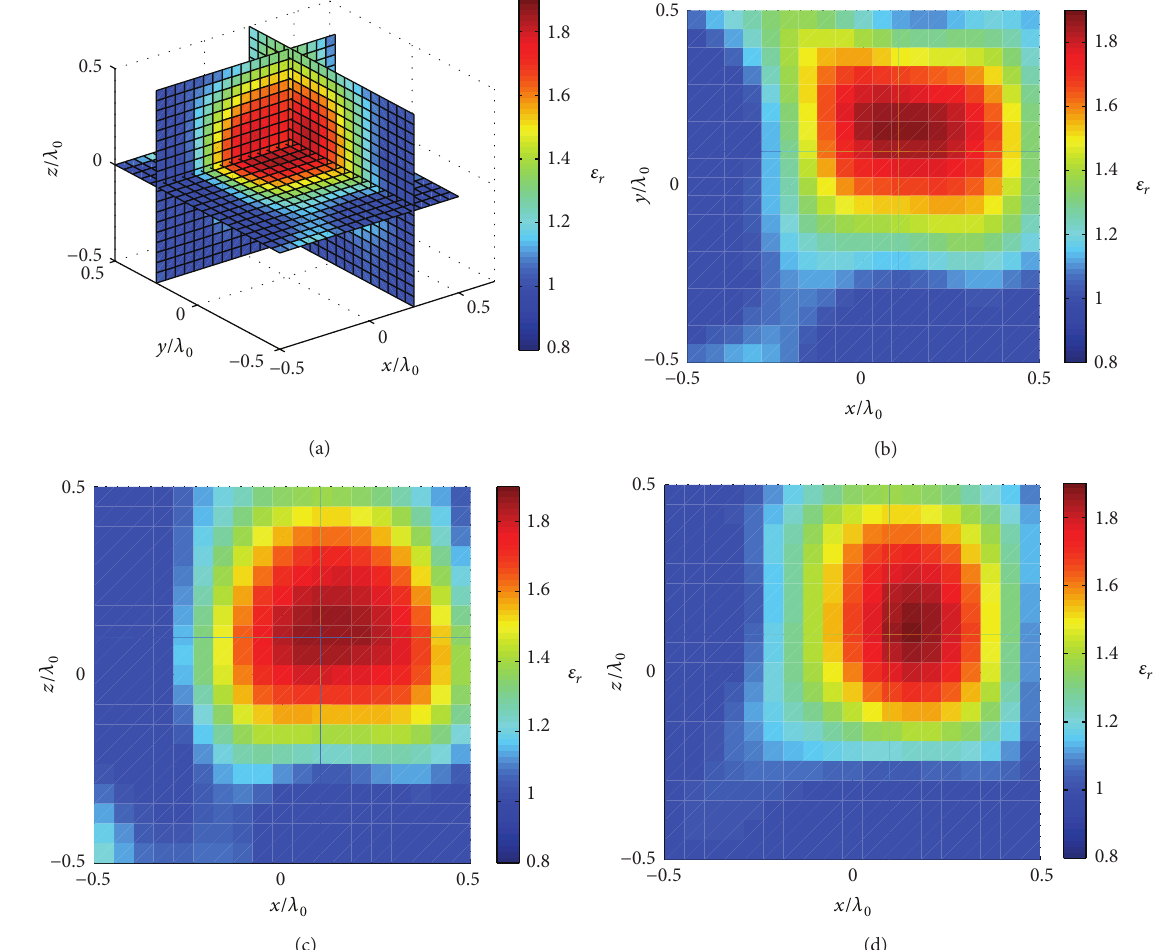
Figure 3: Reconstructed distribution of the relative dielectric permittivity. (a) 3D view; (b) 𝑥𝑦 plane ( 𝑧 = 0.1𝜆 0 ); (c) 𝑥𝑧 plane ( 𝑦 = 0.1𝜆 0 ); (d) 𝑦𝑧 plane ( 𝑥 = 0.1𝜆 0 ). Homogeneous dielectric cube. SNR = 20 dB. 𝐿 = 3